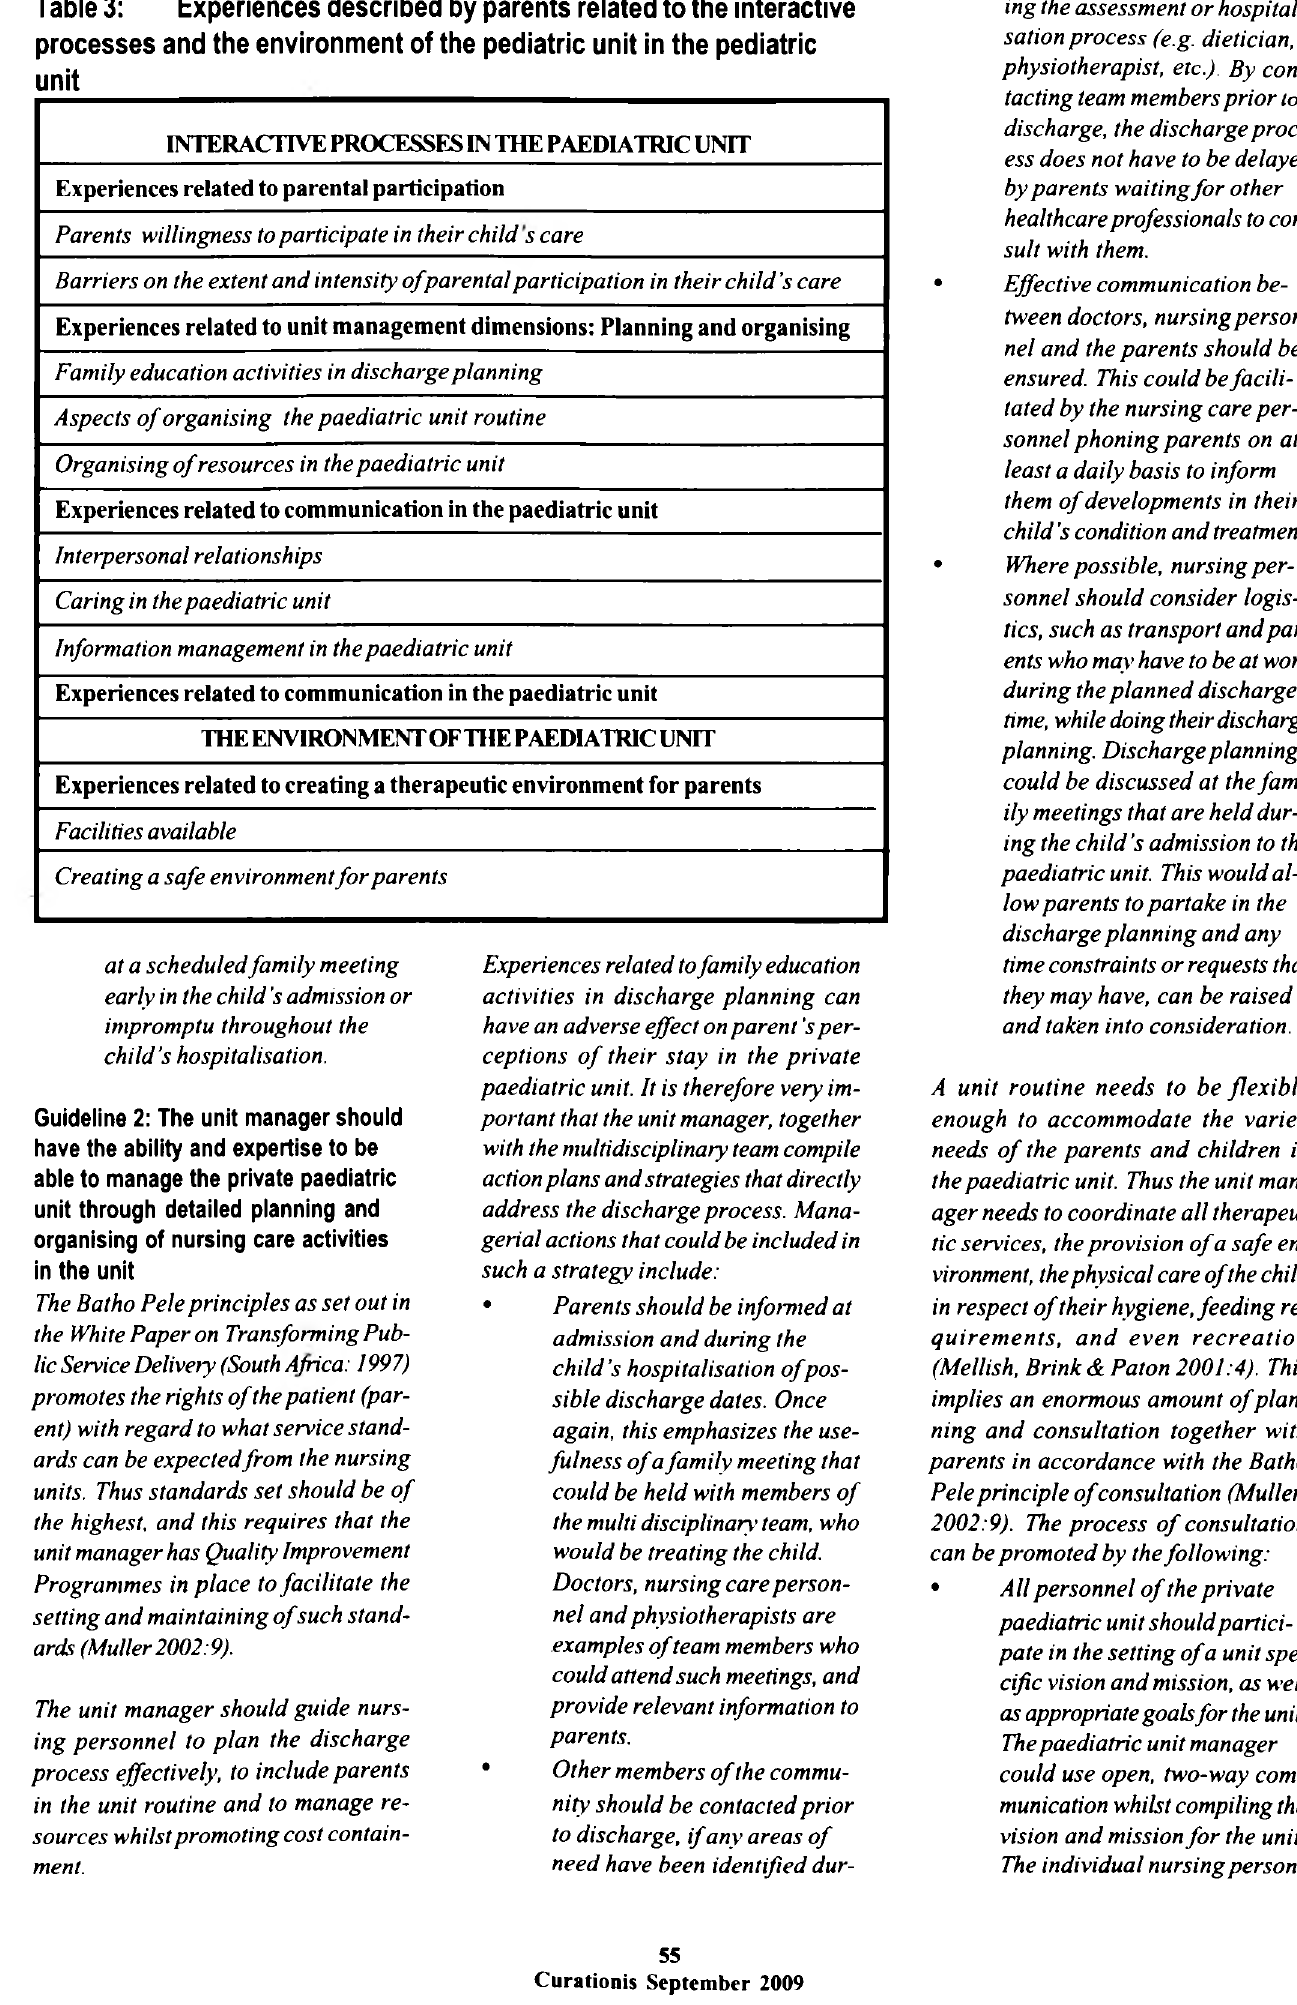
Table 3: Experiences described by parents related to the interactive processes and the environment of the pediatric unit in the pediatric unit INTERACTIVE PROCESSES IN THE PAEDIATRIC UNIT Experiences related to parental participation Parents willingness to participate in their child s care Barriers on the extent and intensity ofparental participation in their child’s care Experiences related to unit management dimensions: Planning and